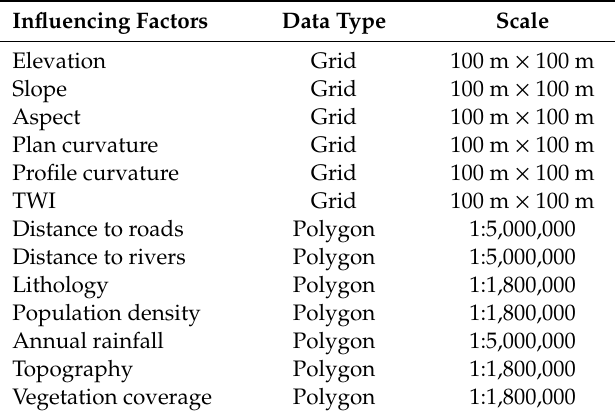
Table 2. Database for influencing factors.